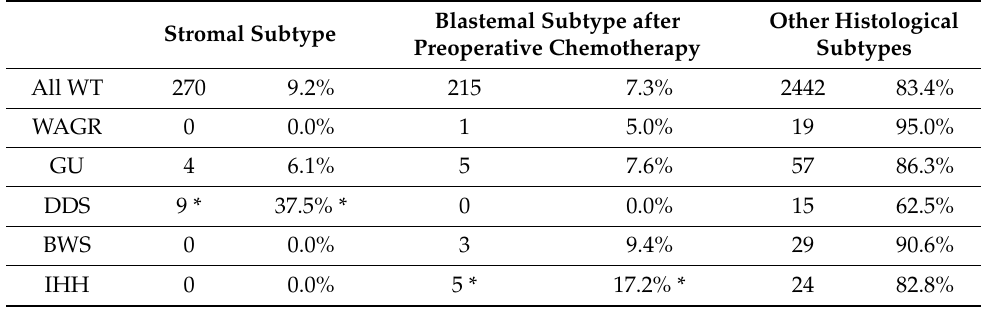
Table 3. Association between histological subtypes and CPS or malformation; * chi-square: p ≤ 0.040. WT: Wilms tumor; GU: Genitourinary malformations; BWS: Beckwith-Wiedemann spectrum; IHH: isolated hemihypertrophy; DDS: Denys-Drash syndrome; WAGR: Wilms tumor, aniridia, genitouri- nary abnormalities, range of developmental